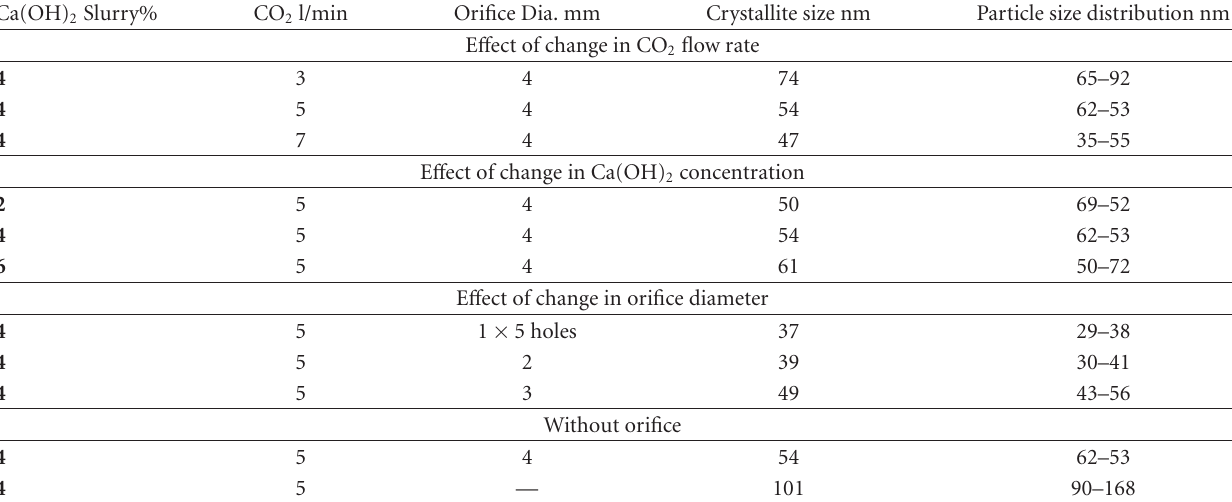
Table 2: E ff ect of slurry concentration and CO 2 flow rates, orifice diameter on crystallite size (calculated from XRD), and particle size distribution (from TEM).